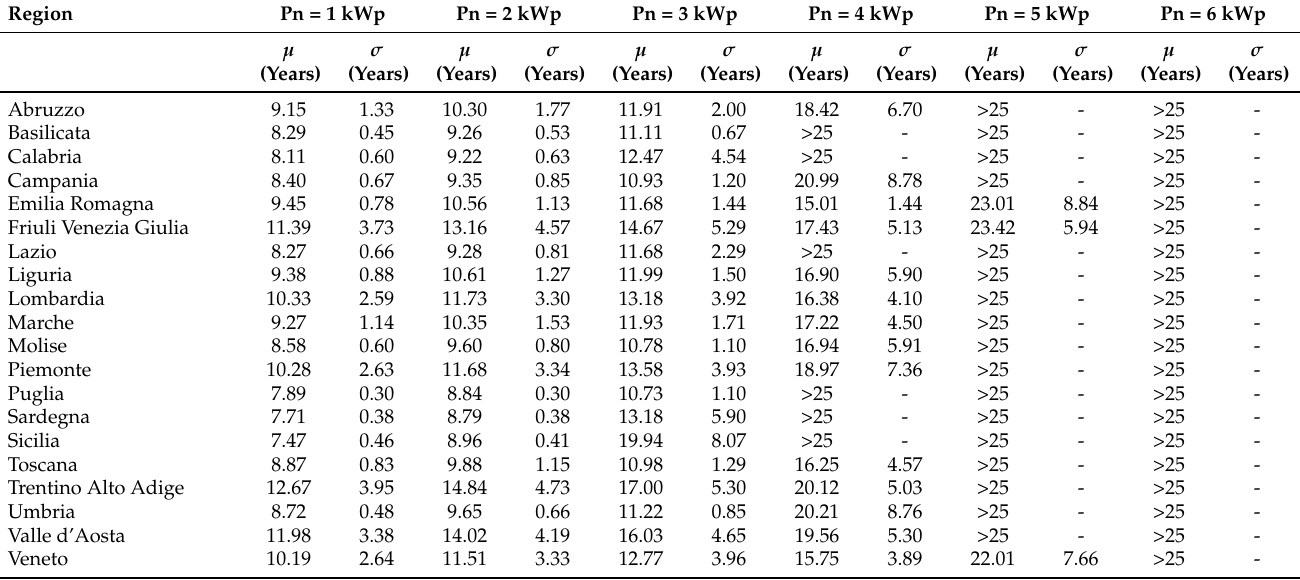
Table 30. DPBT for E L = 4000 kWh with